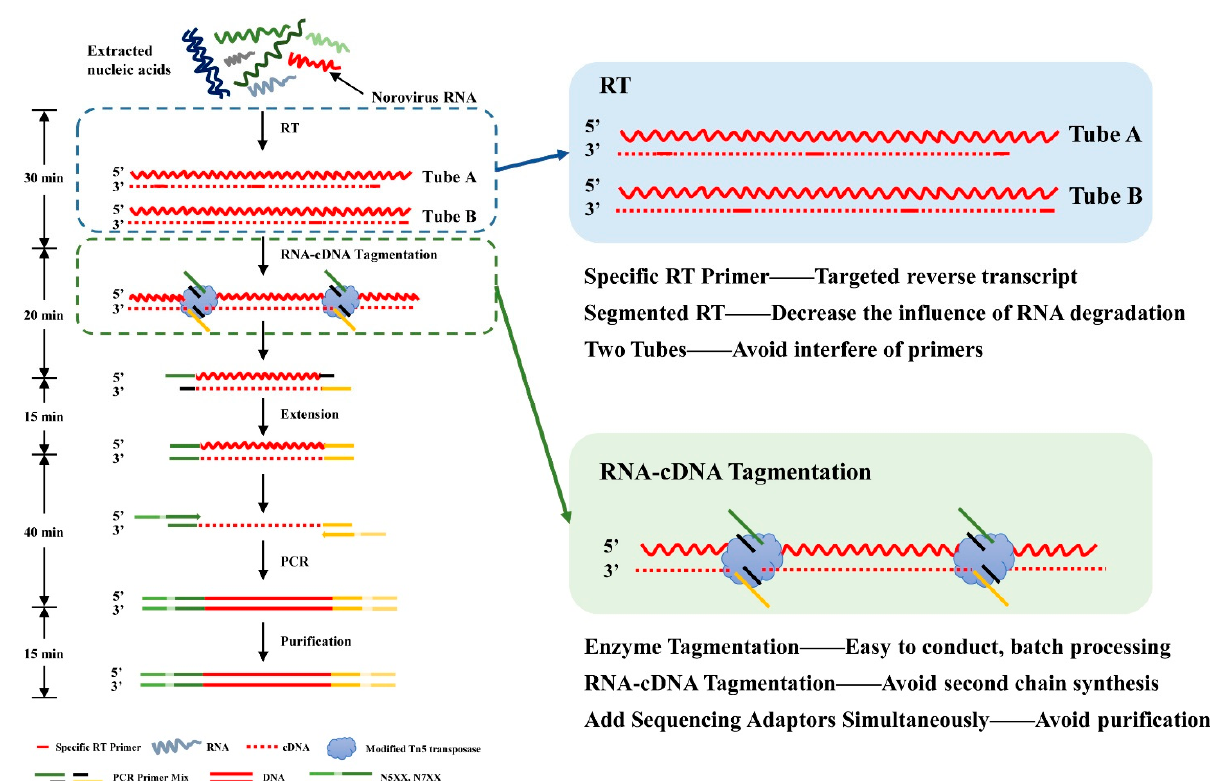
Figure 1. Workflow of the next-generation sequencing (NGS) library preparation strategy based on Transposase-assisted RNA/DNA hybrids Co-tagmEntation (termed TRACE-seq) Library construction processes are listed in the left panel. The main optimizations of this method are marked with two boxes and zoomed to show details with advantages listed in the right panel. The process consists of four components: RNA reverse transcription, RNA/cDNA hybrid tagmentation, PCR amplification, and purification. Specifically, RNA is divided into tube A and B for reverse transcription using primers designed for human noroviruses (HuNoVs). The RNA/DNA hybrid is then tagmented by the modified Tn5 transposase directly. High-fidelity DNA polymerase then amplifies the cDNA into a sequencing library after initial end extension. The purified product is an indexed library which is ready for sequencing.